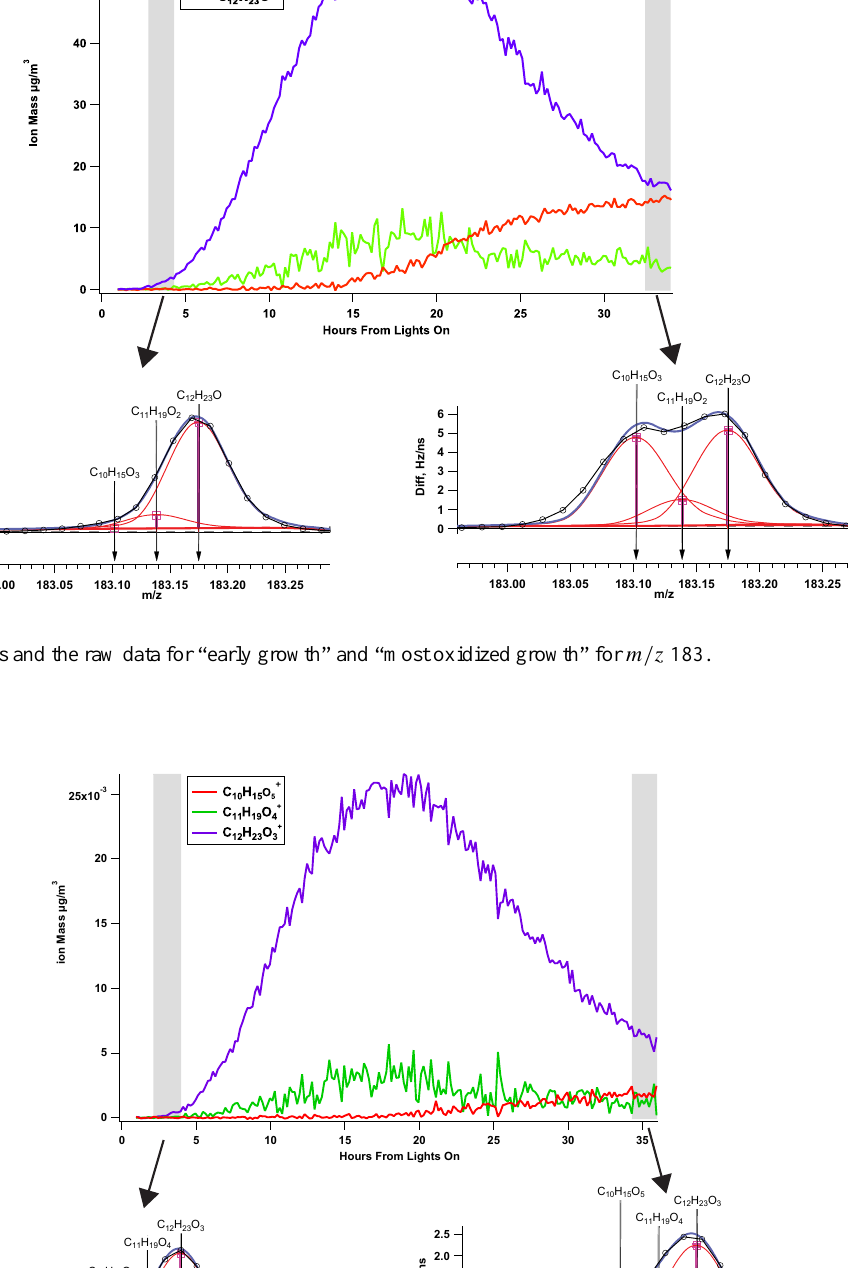
Atmos. Chem. Phys., 12, 11795–11817, 2012